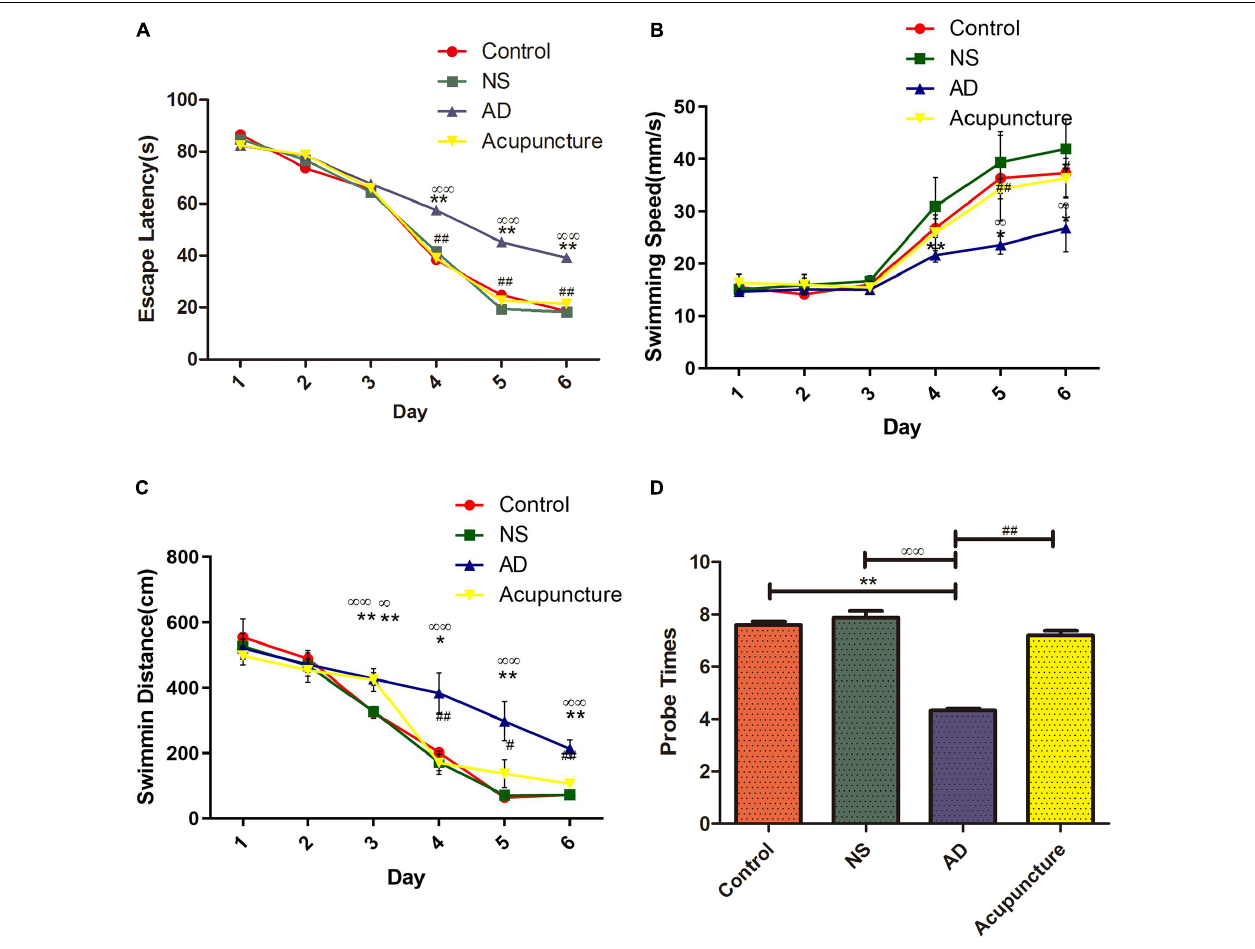
FIGURE 1 | Evaluation of learning and memory capacity in the Morris Water Maze. (A) The mean escape latency from star point to the platform. (B) The mean swimming speed from the star point to the platform. (C) The mean swimming distance. (D) Probe times of trails. Compared with the Control group, ** p < 0.01; compared with the NS group, ∞∞ p < 0.01; compared with the AD group, # p < 0.05, ## p < 0.01 ( n = 5).